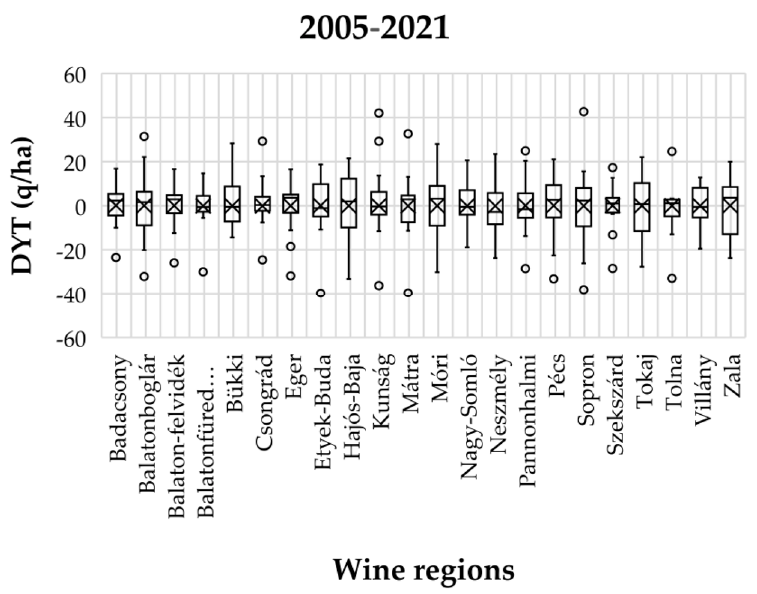
Figure 8. The box diagrams and extreme values of the yield trend deviation (DYT in q/ha) for 22 Hungarian wine regions from 2005–2021.